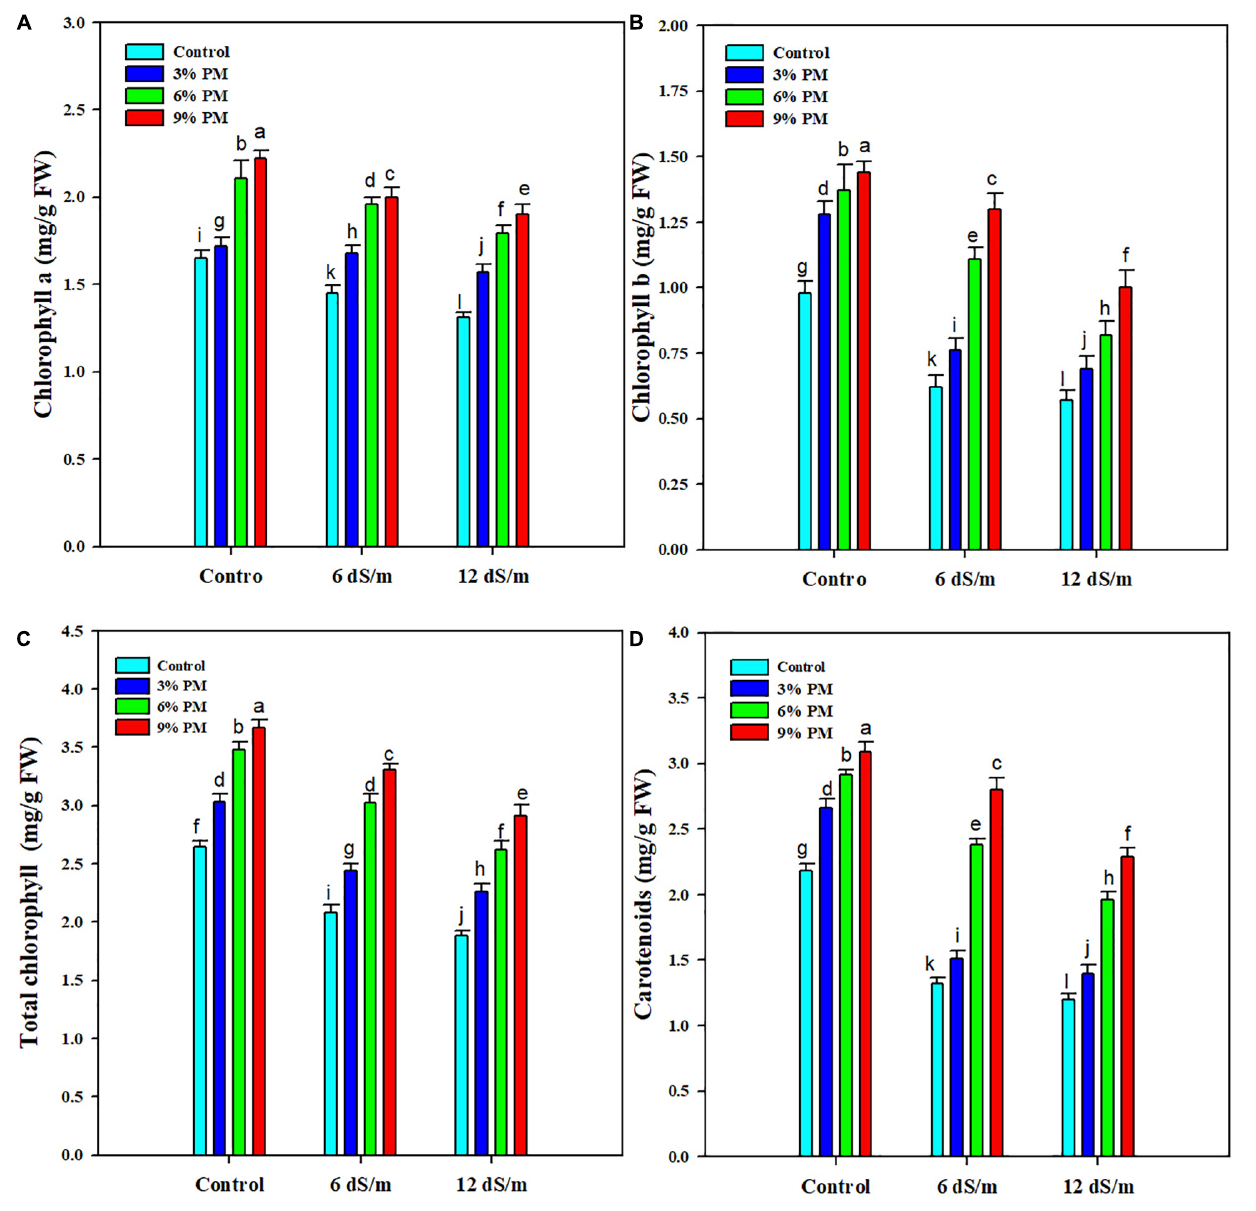
FIGURE 1 | Effect of different levels of press mud application on chlorophyll (A) , chlorophyll (B) , total chlorophyll (C) , and carotenoid (D) contents of rice crop grown under different levels of salinity stress. The bars indicate the means of three replications with ± S.E. and a different letter indicating significant differences at p <